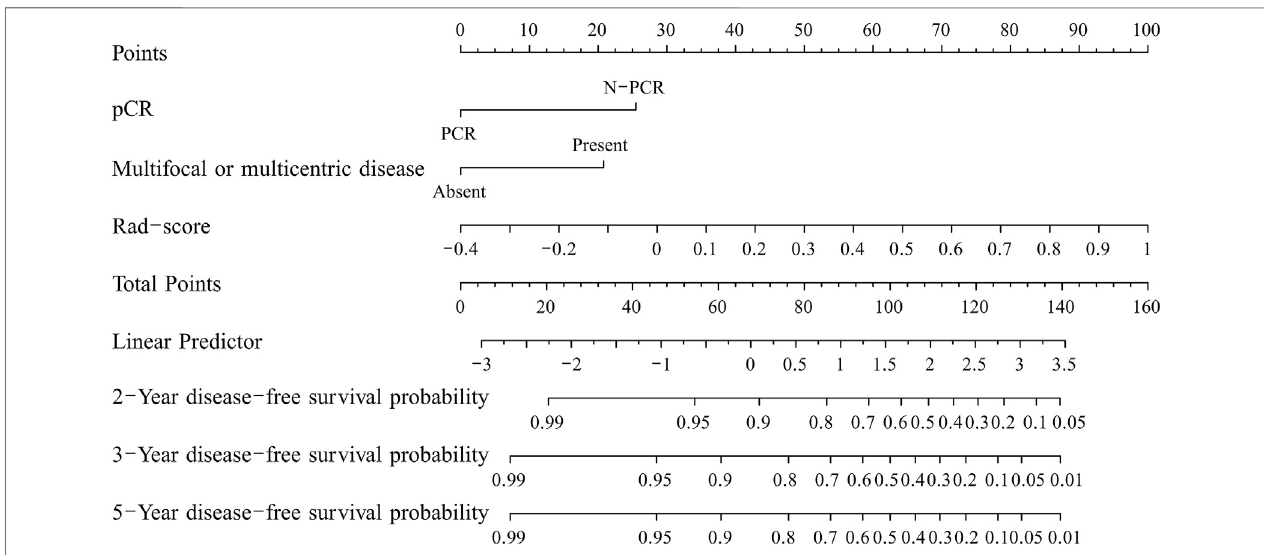
FIGURE 3 | The developed nomogram for predicting disease-free survival in triple-negative breast cancer patients after neoadjuvant chemotherapy.